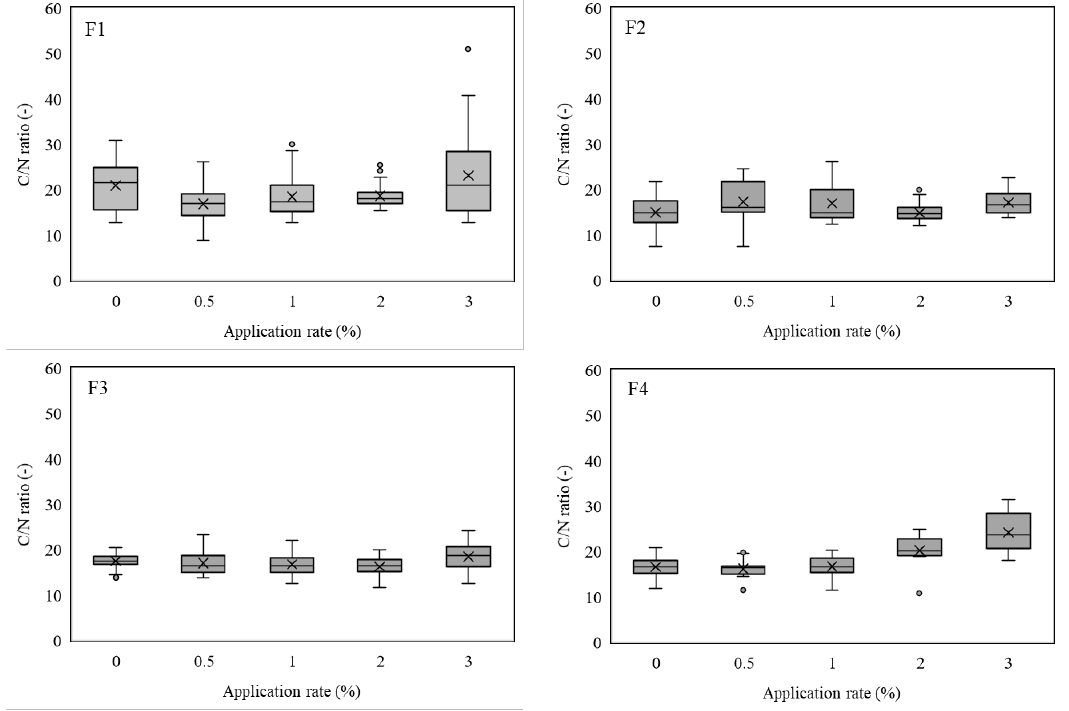
Figure 3. Box plot graph showing the soil C/N with different application rate in F1, F2, F3, and F4. (F1: CBB ash A and pig manure; F2: CBB ash A; F3: CBB ash B and pig manure; F4: CBB ash